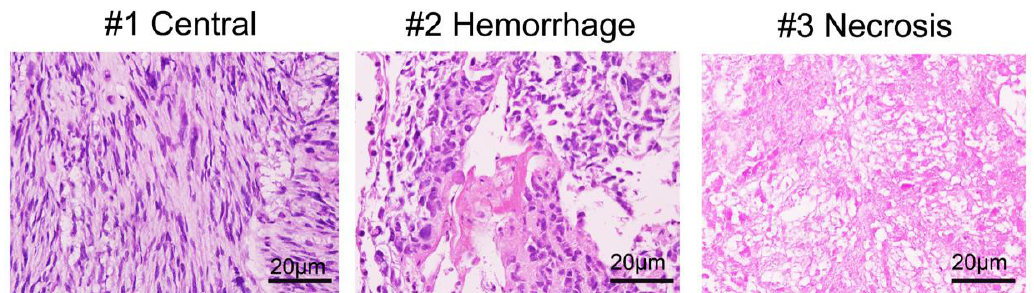
Figure 2. H&E stained sections of the biopsy sites. H&E stained sections (20X) show areas (#1)